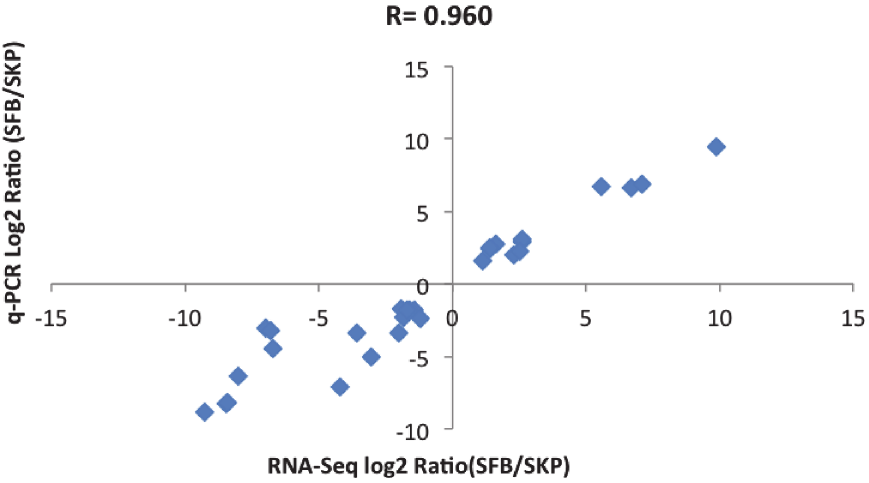
Fig 6. Correlation between RNA-Seq and qRT-PCR data of selected genes. Pearson correlation coefficient(r = 0.960) was used to determine the similarity in gene expression pattern between RNA-Seq and